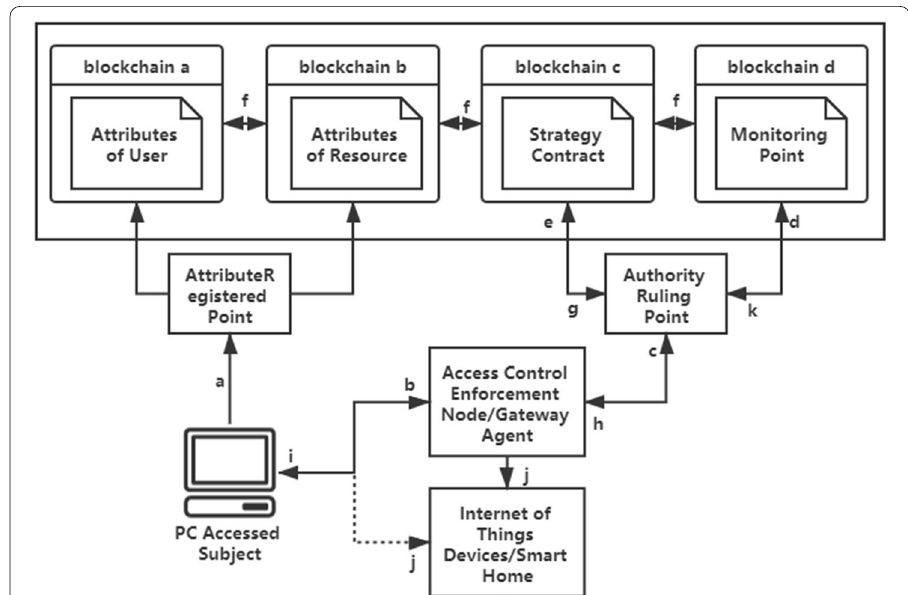
Fig. 3 Access control flow. The function of each module in the model and implementation process of access control is as follows:device registration, submit access information, application for access decision, security monitoring, call contract judgement, inter-contract invocation, generate the ruling result, return the verdict, the token is delivered to the access subject, the subject accesses the resource device through the